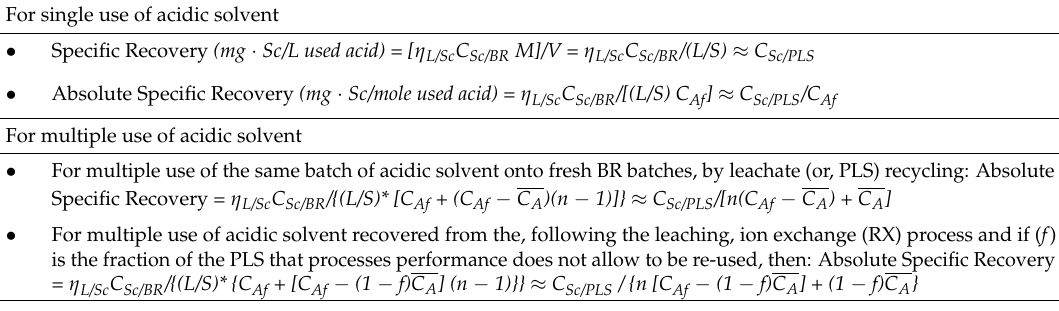
Table 1. Definitions of Specific Recovery for the Acidic Leaching of the Greek BR.